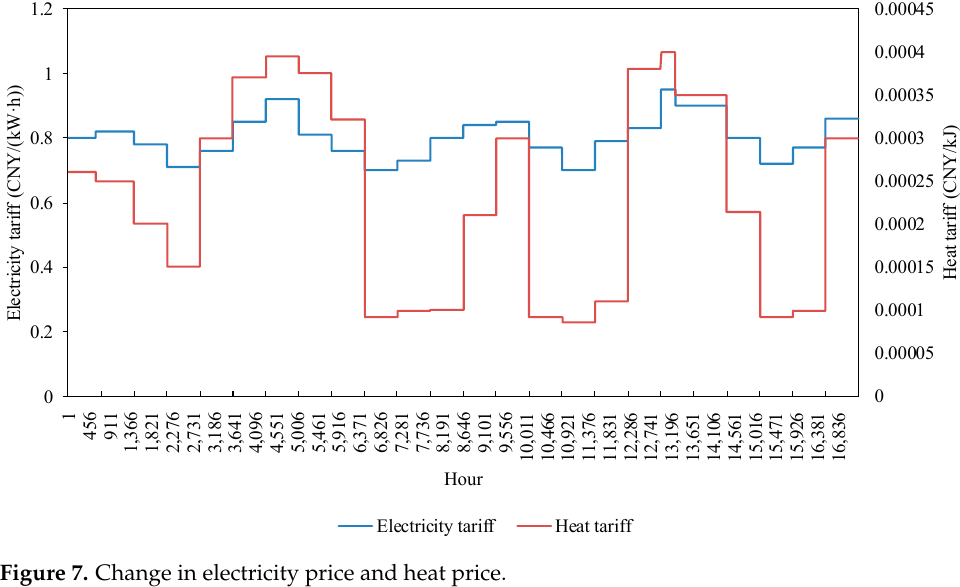
Figure 7. Change in electricity price and heat price. Table 5. Parameters related to FGD systems.